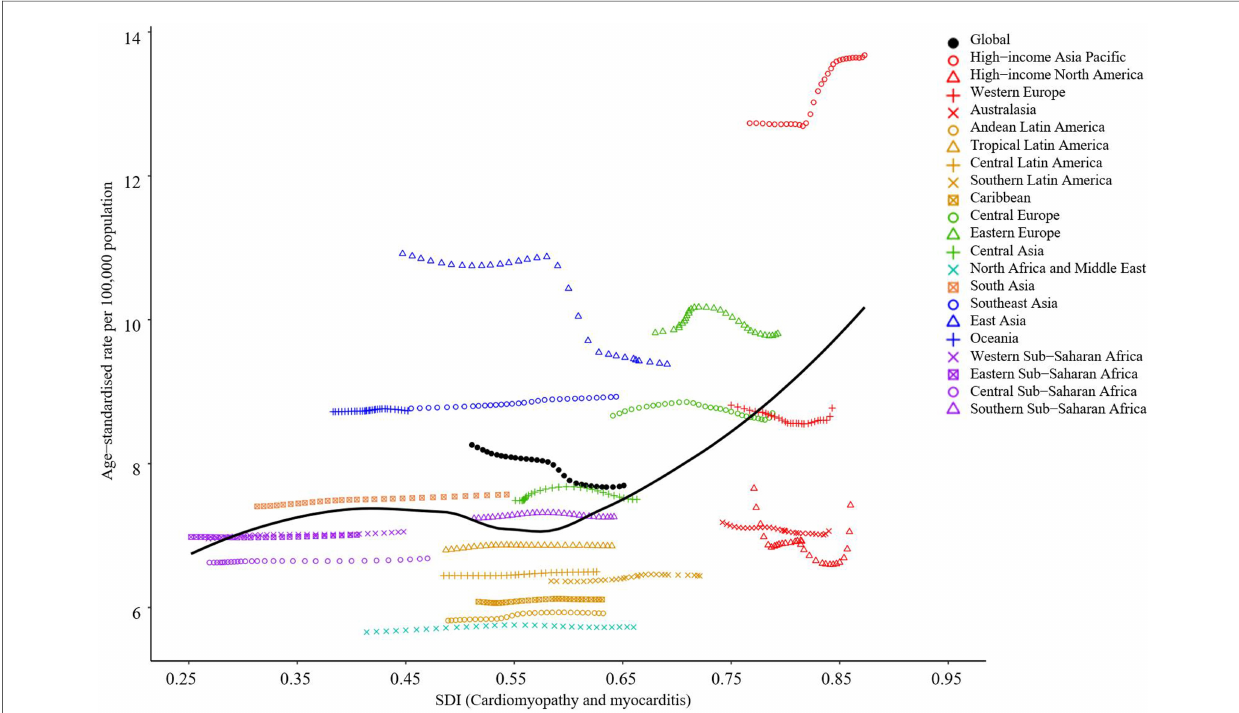
FIGURE 2 Age-standardized incidence of childhood myocarditis and cardiomyopathy per 100,000 children by 21 global regions and SDI, 2019. Globally, the age- standardized incidence of childhood myocarditis and cardiomyopathy declined with the increase in SDI. At the regional level, SDI changes in most areas did not make any meaningful difference in 2019. In East Asia, the increase of SDI was associated with a decrease of incidence rate. In High income Asia Paci fi c, the increase of SDI was associated with an increase of incidence rate. SDI, sociodemographic